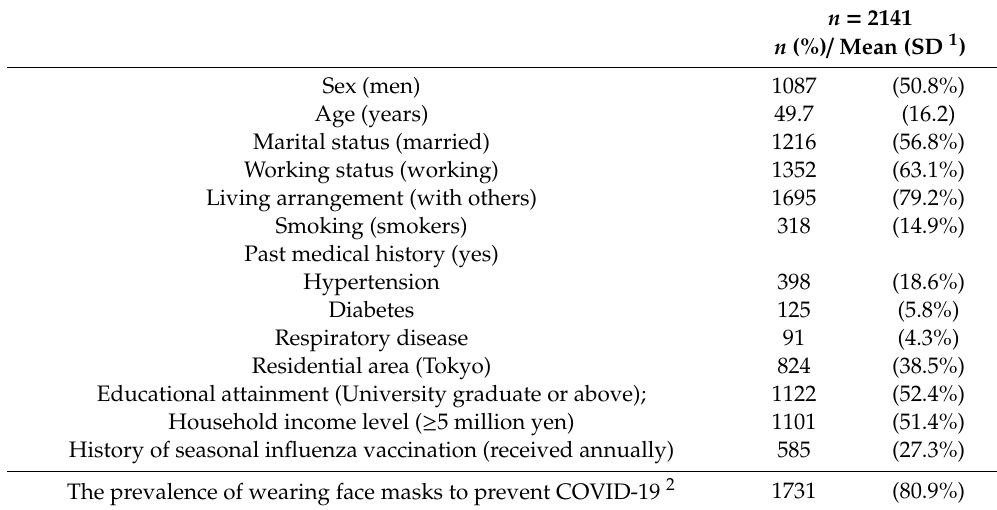
Table 2. Participant characteristics and the prevalence of wearing face masks to prevent